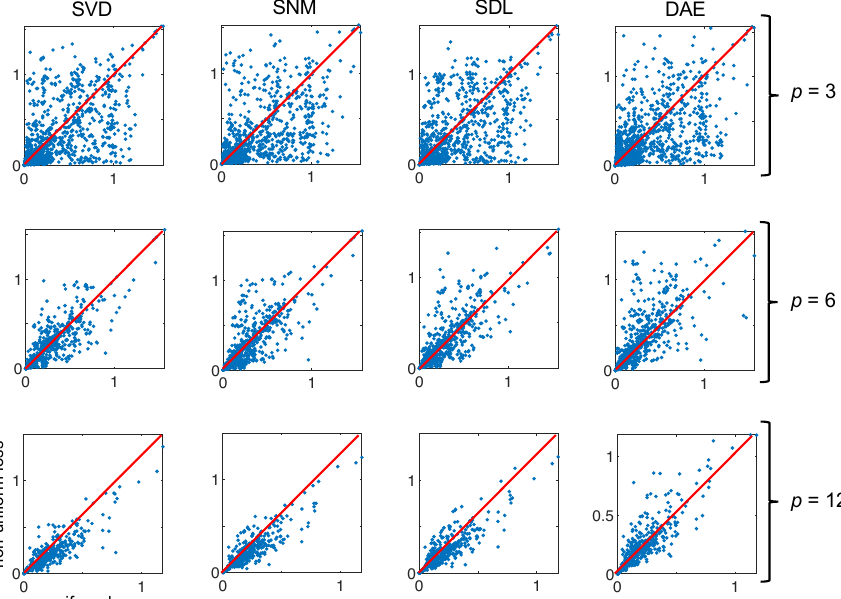
Figure 8. Here, we plot the uniform loss against the non-uniform loss for the four derived sampling protocols at three different encoder rates for all the spectra in our validation set ( n V = 1417 ) . When the majority of the points fall below the y = x line (shown in red), this means that the non-uniform approach outperforms the uniform method (e.g., SVD, p =